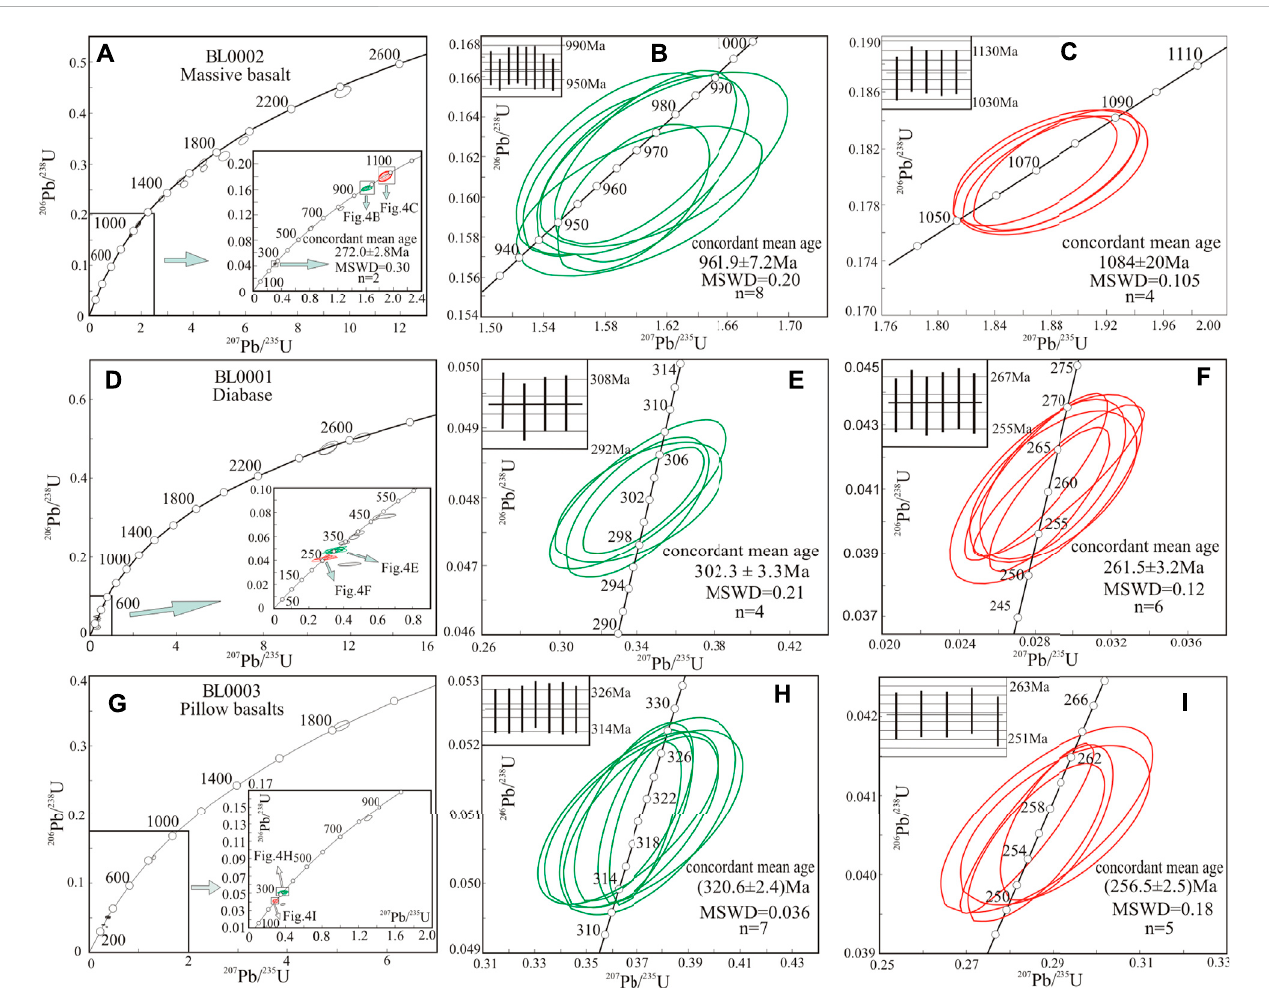
FIGURE 5 Concordia U-Pb diagrams of zircons from basic igneous rocks in the Bairin Right Banner area, Inner Mongolia. (A – C) massive basalt (BL0002); (D – F) diabase (BL0001); (G – I) pillow basalt (BL0003).